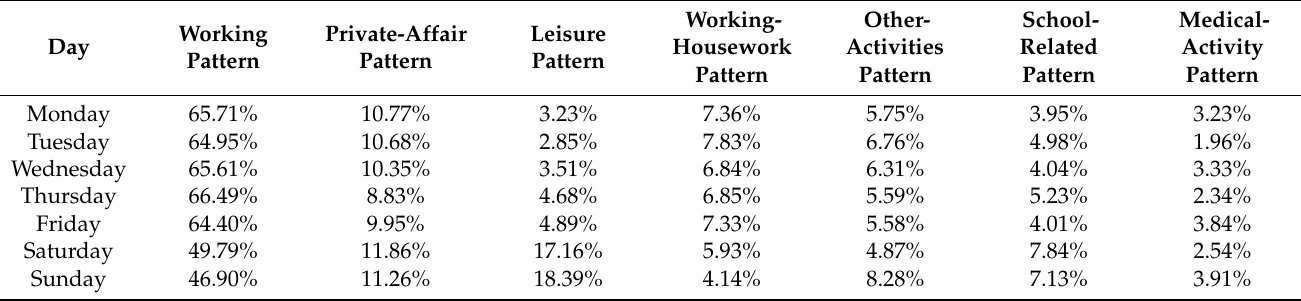
Table 2. Distribution of the 7 activity patterns in 7 days of a